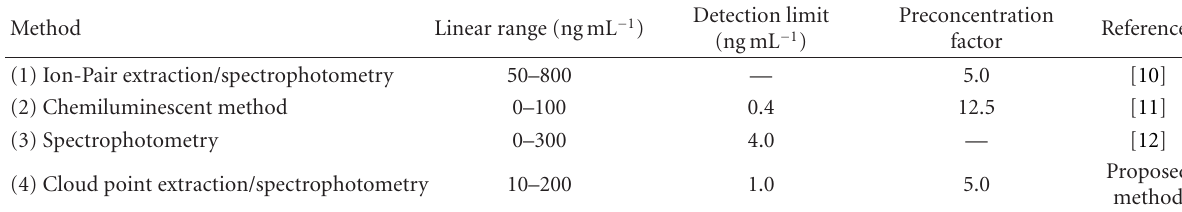
Table 6: Comparison of the proposed method with other